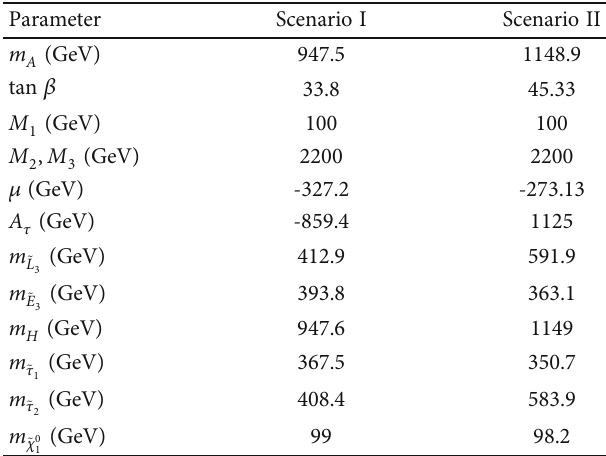
Table 1: Benchmark points of Scenario I and Scenario II that are used to develop the collider analysis.